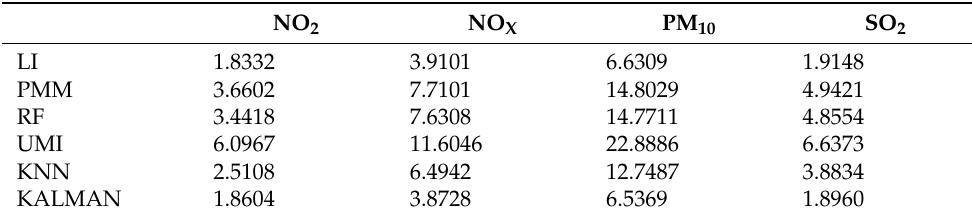
Table 11. RMSE STATION ST 20.